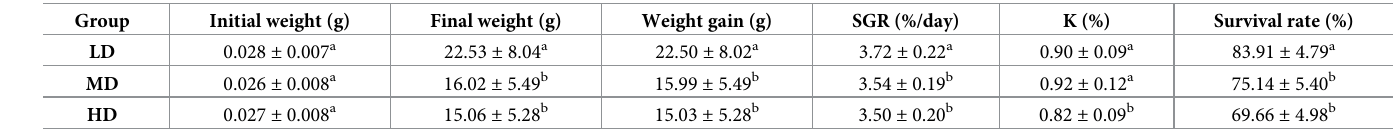
Sexual size dimorphism in physiological indices by density The physiological indices of yellow perch are shown in Table 5. Within each density group, females in all three densities showed significantly higher GSI than ( P < 0 . 05 ) even at the size of ~12 cm. There were no significant differences detected for the GSI when comparing any of the density groups for both males and females ( P > 0 . 05 ), suggesting the density effect on gonadal development at the size below ~12 cm was minimum. There was no significant difference in HSI between females and males within each group of the three densities ( P > 0 . 05 ) (Table 5); however, the HSI significantly increased in the fish reared in the LD group when compared to the MD and HD ( P < 0 . 05 ), suggesting high density affected liver reserves or functions. Compar- ing VSI between males and females within each density group found that only in LD female was VSI significantly higher than males, and no significant differences ( P > 0 . 05 ) were detected in Table 4. Growth performance and survival rate of yellow perch reared at different density.